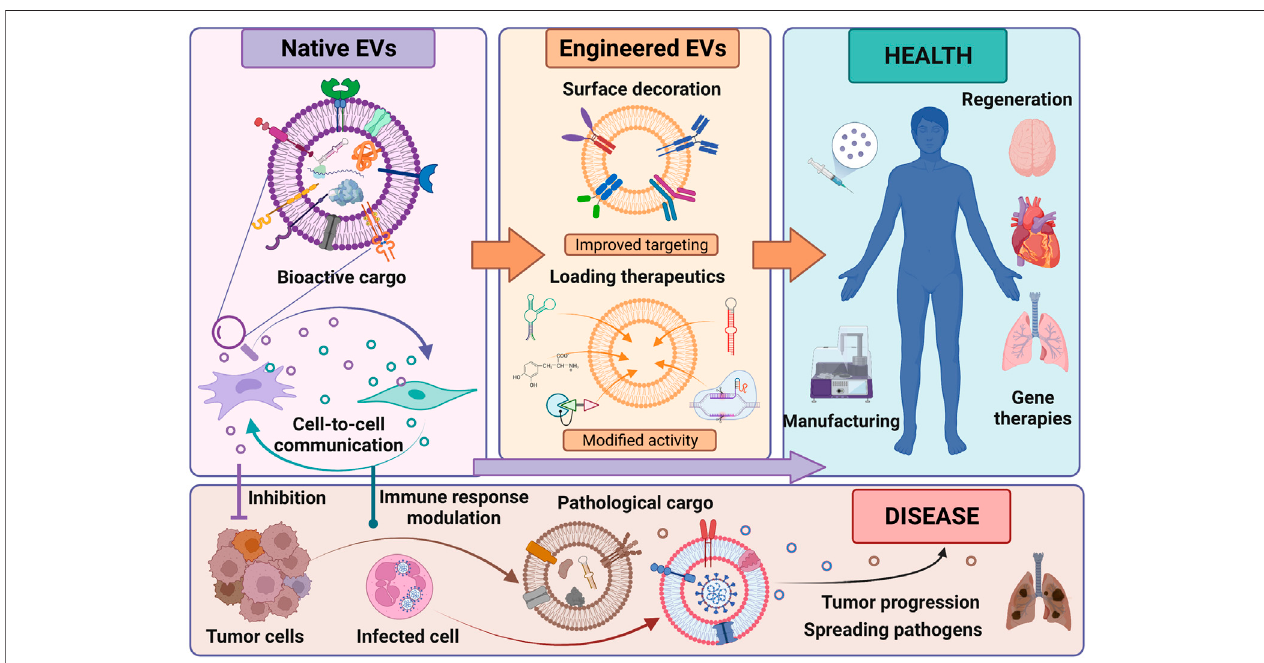
FIGURE 1 | Characteristics, bioengineering and role of extracellular vesicles (EVs) in health and disease. EVs contain bioactive cargo in the form of proteins, lipids and nucleic acids which exert biological effects on target cells and thereby in fl uence their fate. To improve functionality and speci fi city of EVs, they can be engineered by surfacemodi fi cationand/orloadingaspeci fi ctherapeuticcargo.Nativeandmodi fi edEVscanbeusedasnext-generationcell-freetherapeuticstoimprovehealth.Onthe contrary, EVs released in pathological conditions by, e.g. cancer cells or infected cells, participate in disease spreading and progression.